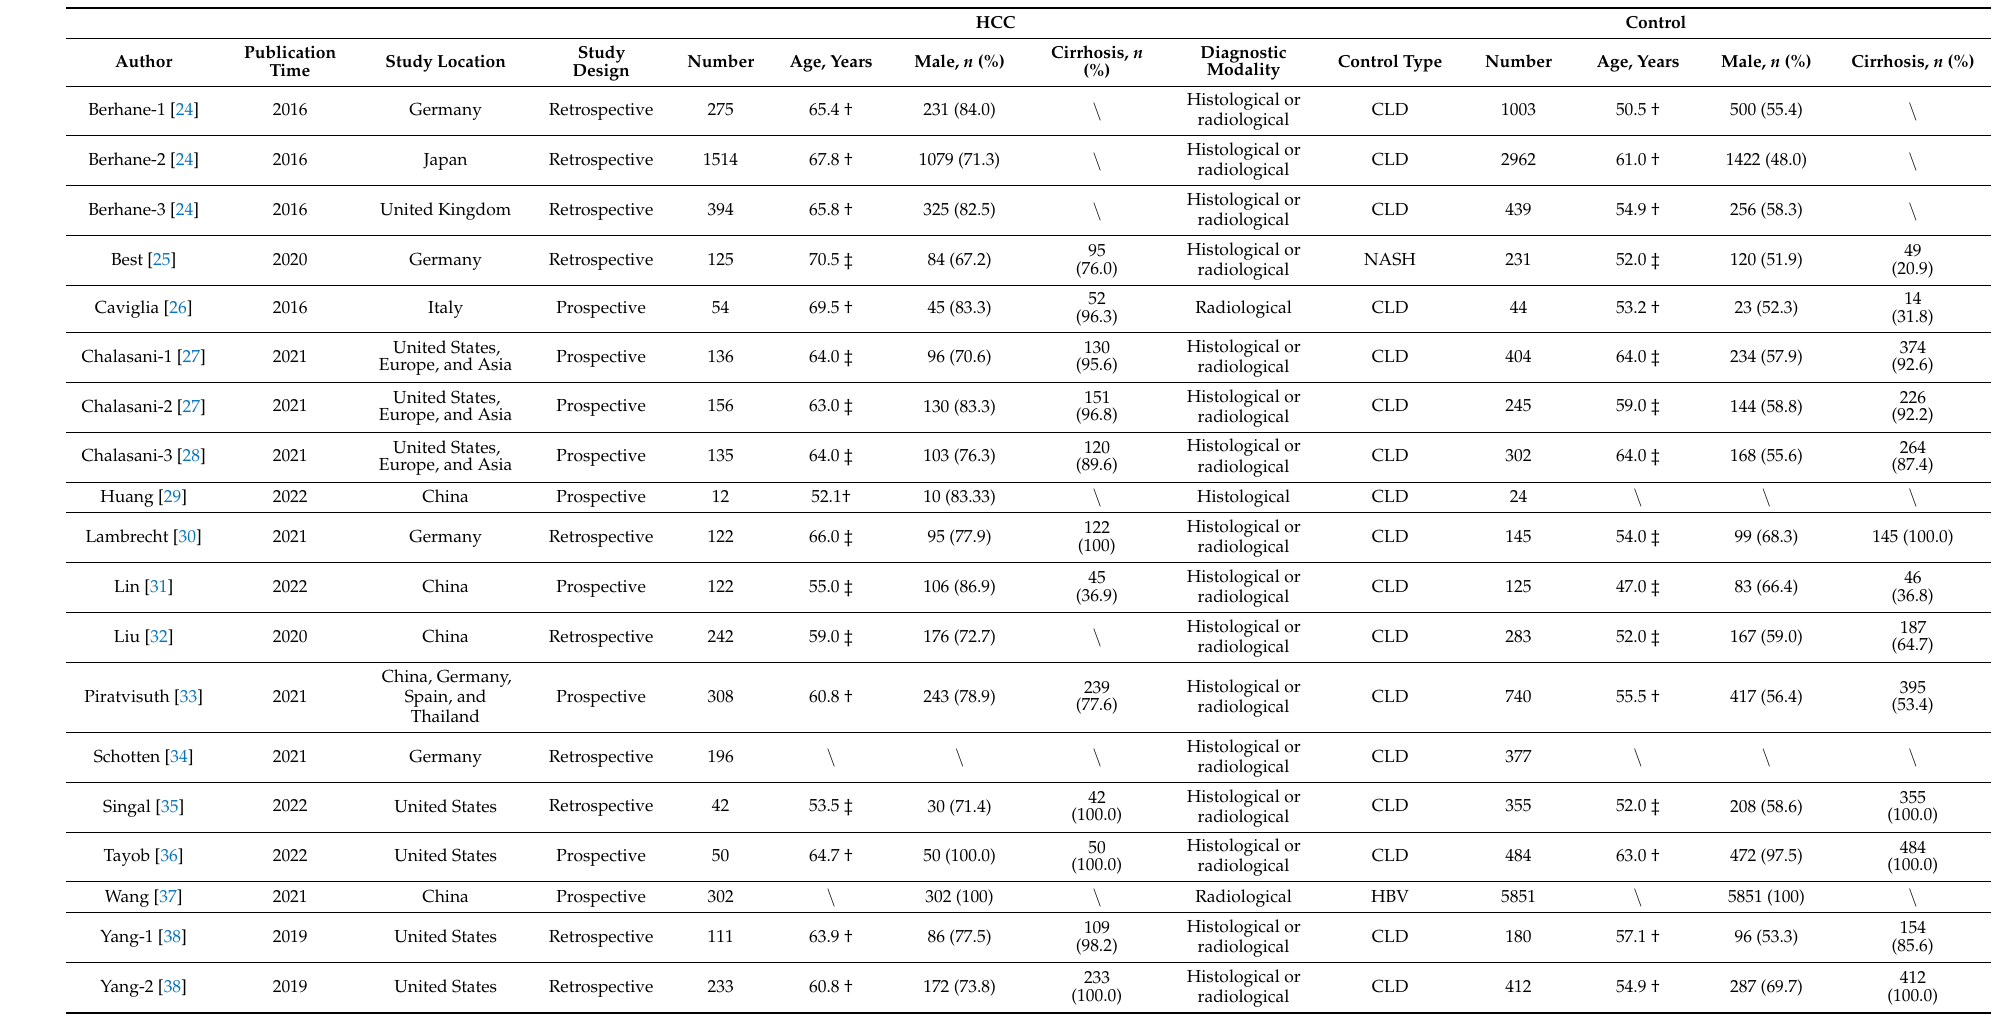
Table 1. Characteristics of